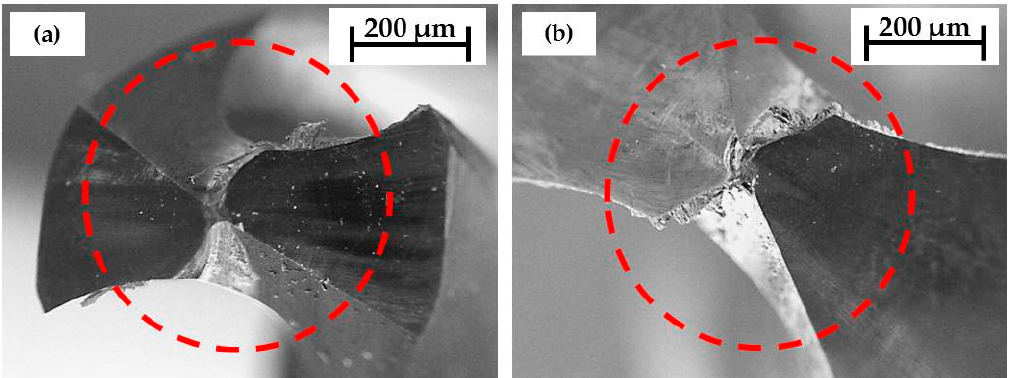
Figure 11. Post-machining tool conditions: ( a ) 6 mm drill bit and ( b ) 10 mm drill bit.